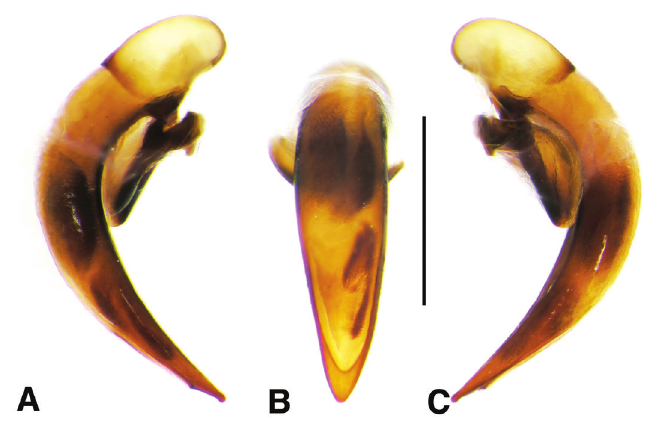
Figure 51. Digital images of male genitalia of Selenophorus palliatus species group, in part, S. woodruffi Ball & Shpeley. A right lateral aspect B dorsal aspect C left lateral aspect. Scale bar 1